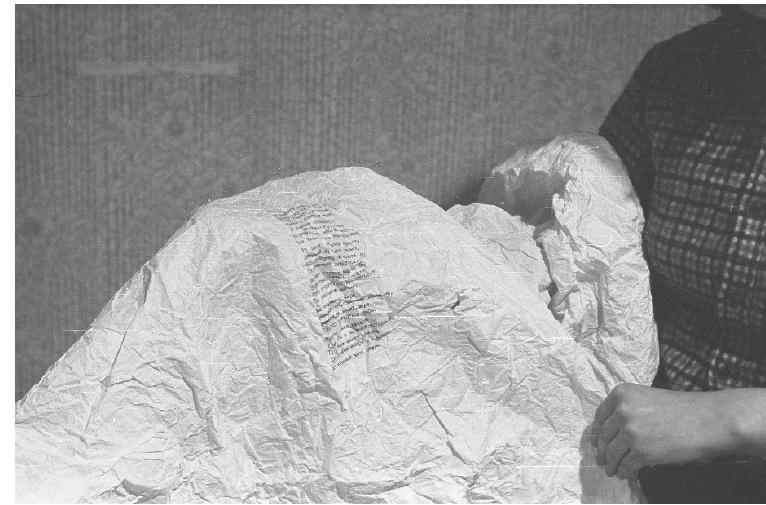
Figure 12. Stolpovskaya. A Poem of Boris Pasternak . 1978–79. Gouache and typewritten text on paper. 49.7 cm × 61.8 cm. Installation view. Courtesy of the artist.